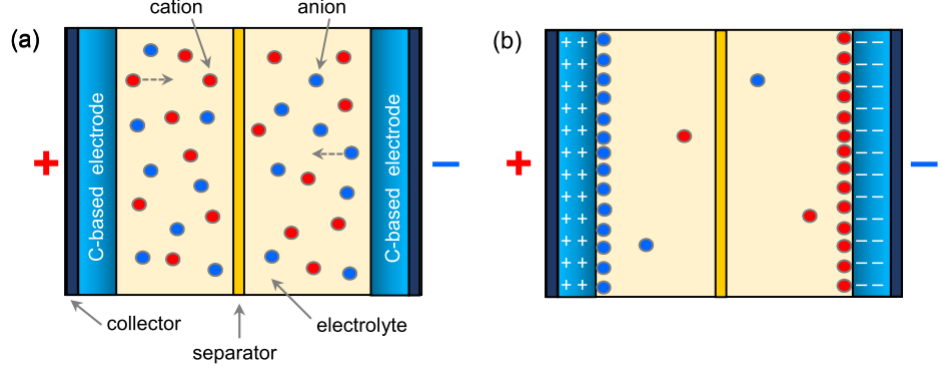
Figure 19. Schematic illustration of a supercapacitor in ( a ) discharged and ( b ) charged states.